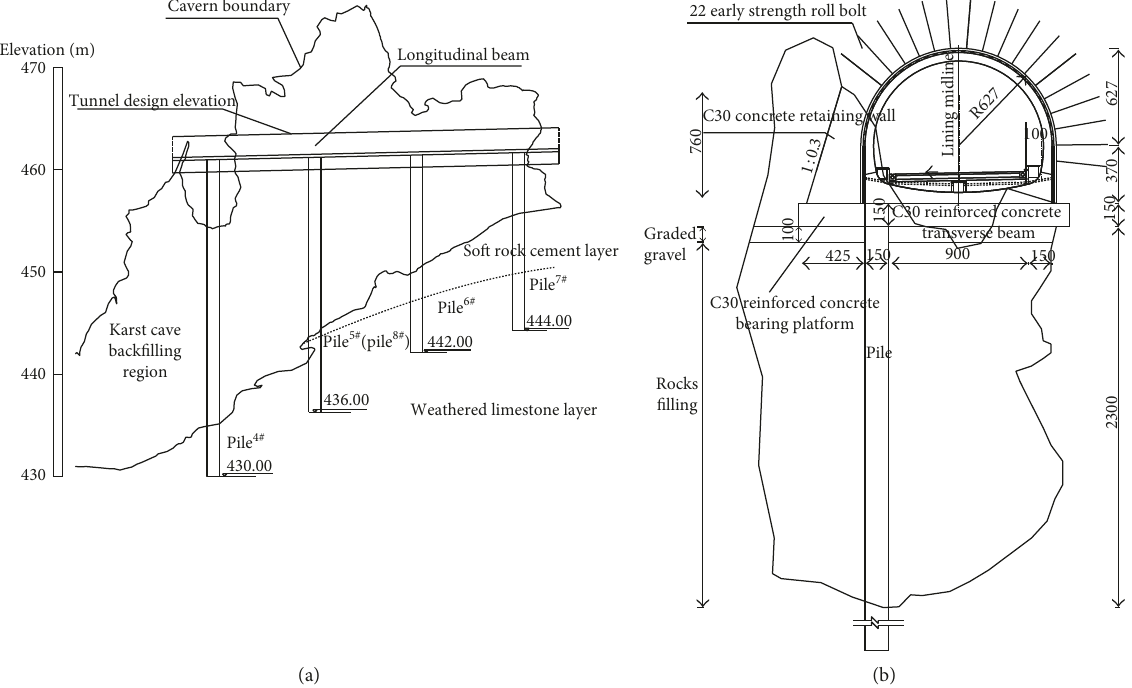
Figure 2: Treatment structure: (a) the longitudinal section of the treatment structure; (b) the cross section of K14+385.